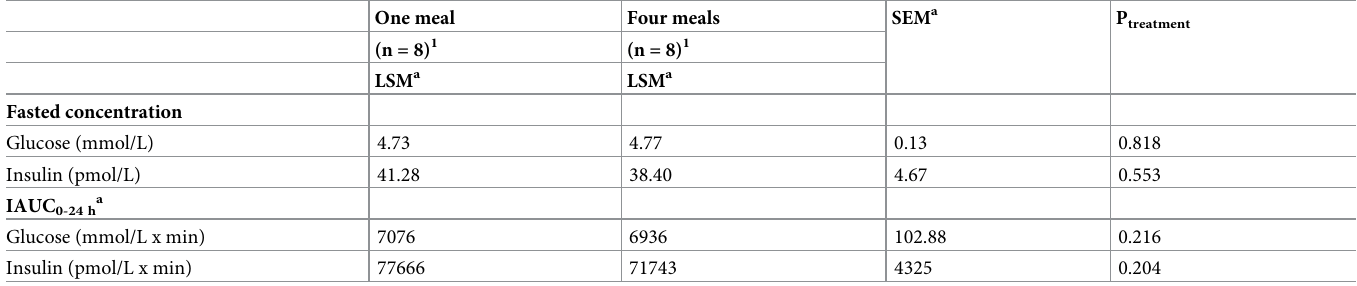
a IAUC, incremental area under the curve; LSM, least square means; SEM, standard error of the mean. 1 Eight cats were used and 4 of 8 repeated one of the two treatments, each mean represents 11 experimental